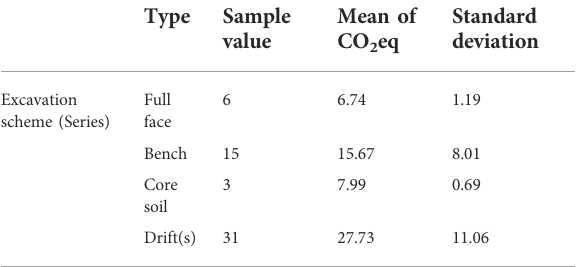
TABLE 7 Summary of the average carbon emission equivalent values for different excavation schemes (series).